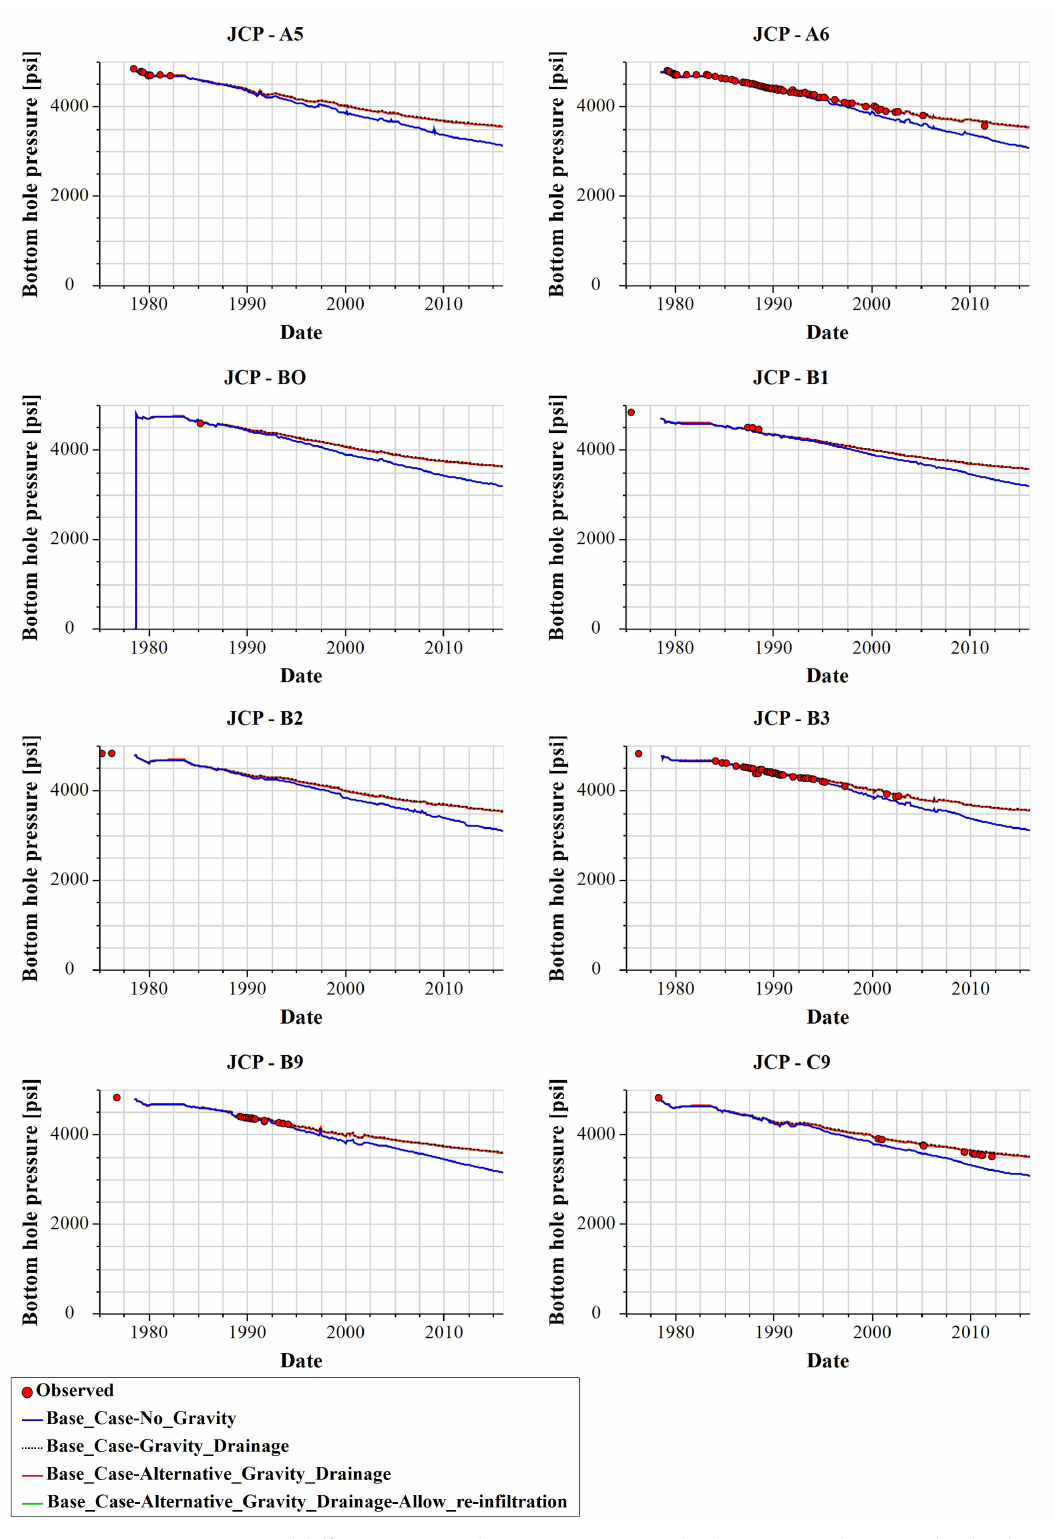
Figure 15. Comparison of different gravity drainage options in the history-matching results for the bottom hole pressure (BHP) in eight wells. The lower bottom hole pressure response (the blue line) represents the reservoir behavior when the gravity neglected while the other overlapped lines represent the different gravity drainage